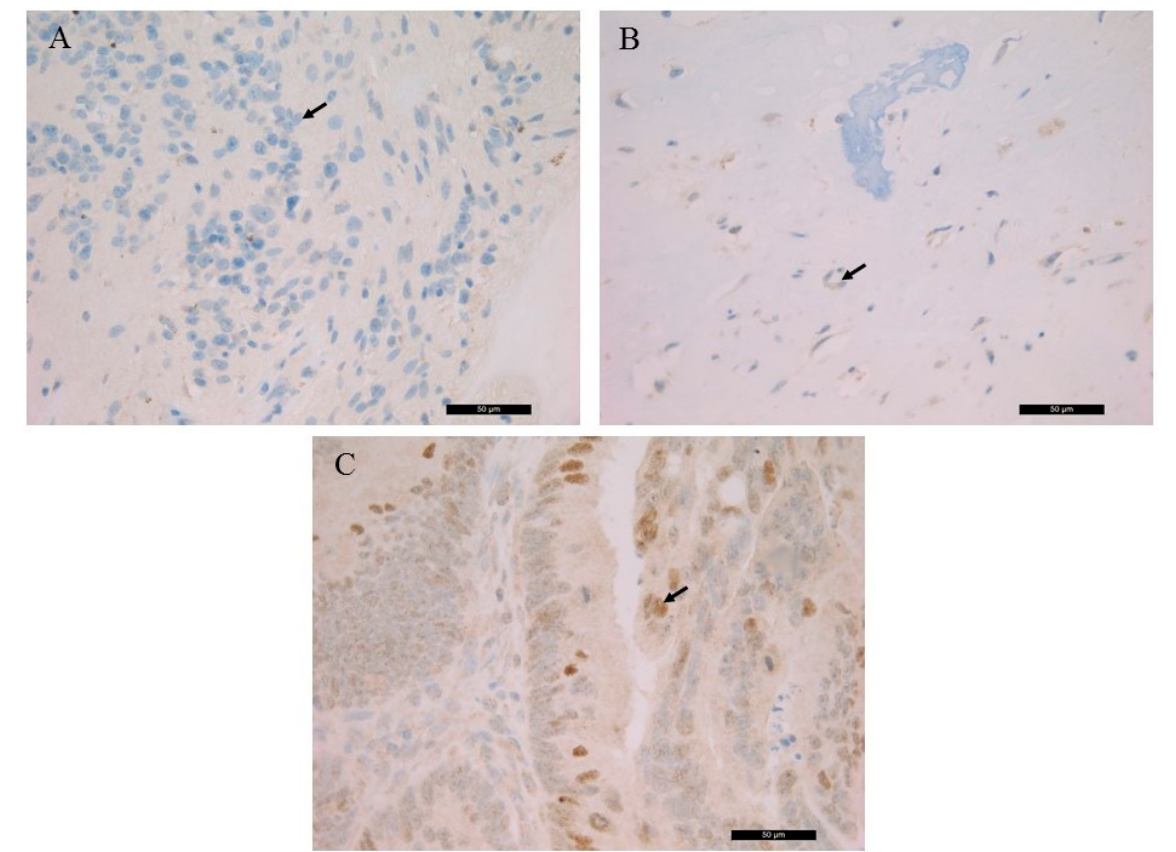
Figure 2. Immunohistochemistry of the RB protein. ( A ) retinoblastoma (S1), ( B ) left orbital bone (S3), ( C ) colorectal adenocarcinoma control. Arrows indicate the immunohistochemistry (IHC)-negative cell nuclei of retinoblastic/chondroblastic tumors and the positive nuclear staining in adenocarcinoma cells (magnification: ×40).